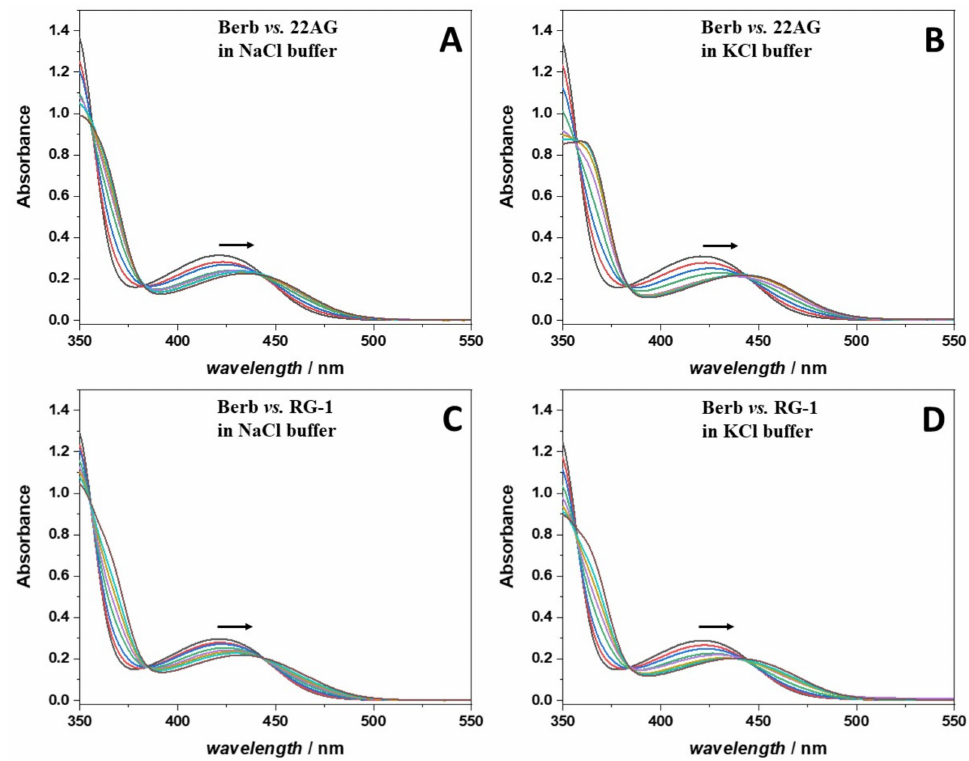
Figure 2. UV/Vis absorption spectra of a 250 µ M berberine (Berb) solution at increasing concen- trations of: ( A ) 22AG in Na + containing buffer; ( B ) 22AG in K + containing buffer; ( C ) RG-1 in Na + containing buffer, and ( D ) RG-1 in K + containing buffer. The concentration of the quadruplexes (22AG or RG-1) was: 10 µ M (red lines), 20 µ M (blue lines), 40 µ M (green lines), 60 µ M (violet lines), 80 µ M (dark yellow lines), 100 µ M (cyan lines), and 150 µ M (brown lines). The spectra of berberine in the absence of any quadruplex are reported as black lines. All spectra were recorded at 25 ◦ C using a 0.3 cm path length quartz cuvette in 30 mM Tris buffer, pH 7.4, with the addition of 100 mM of NaCl or KCl. The arrows indicate the direction of the shift of the absorption maximum in the berberine spectrum with increasing concentrations of